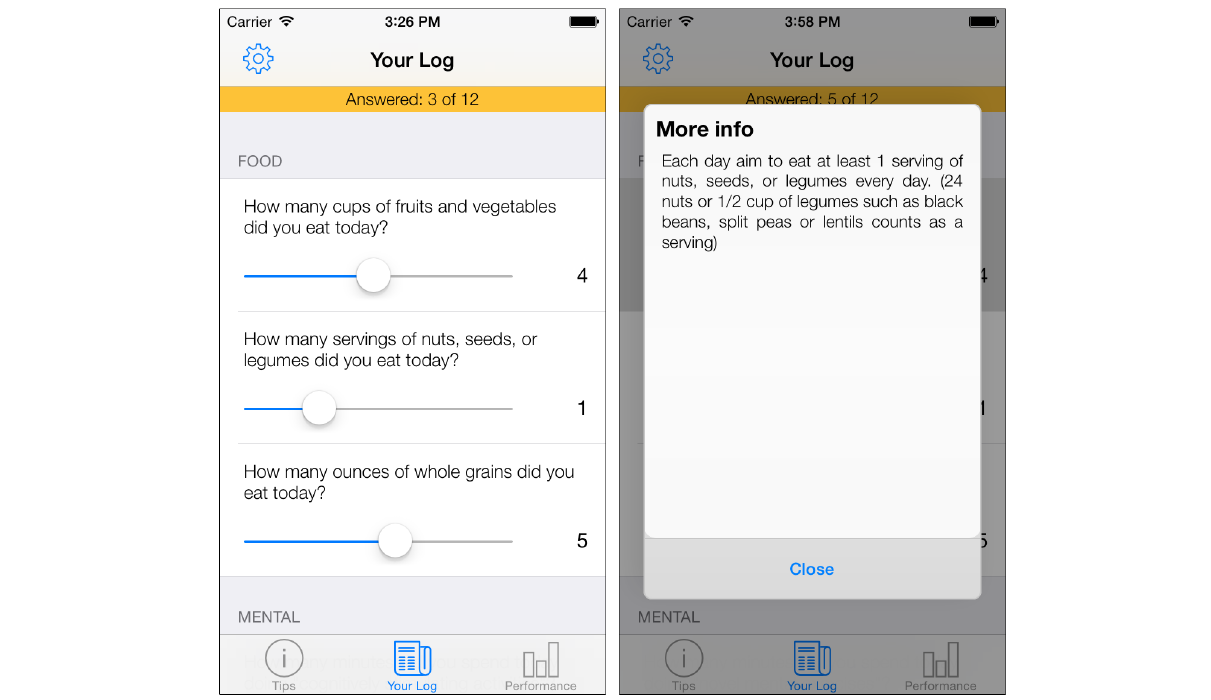
Figure 3. Log tab main screen showing list of questions ordered by domain (left). The sliders can be dragged to adjust logged amount. Dialog box containing additional information displayed for a question regarding servings of nuts, seeds, and legumes